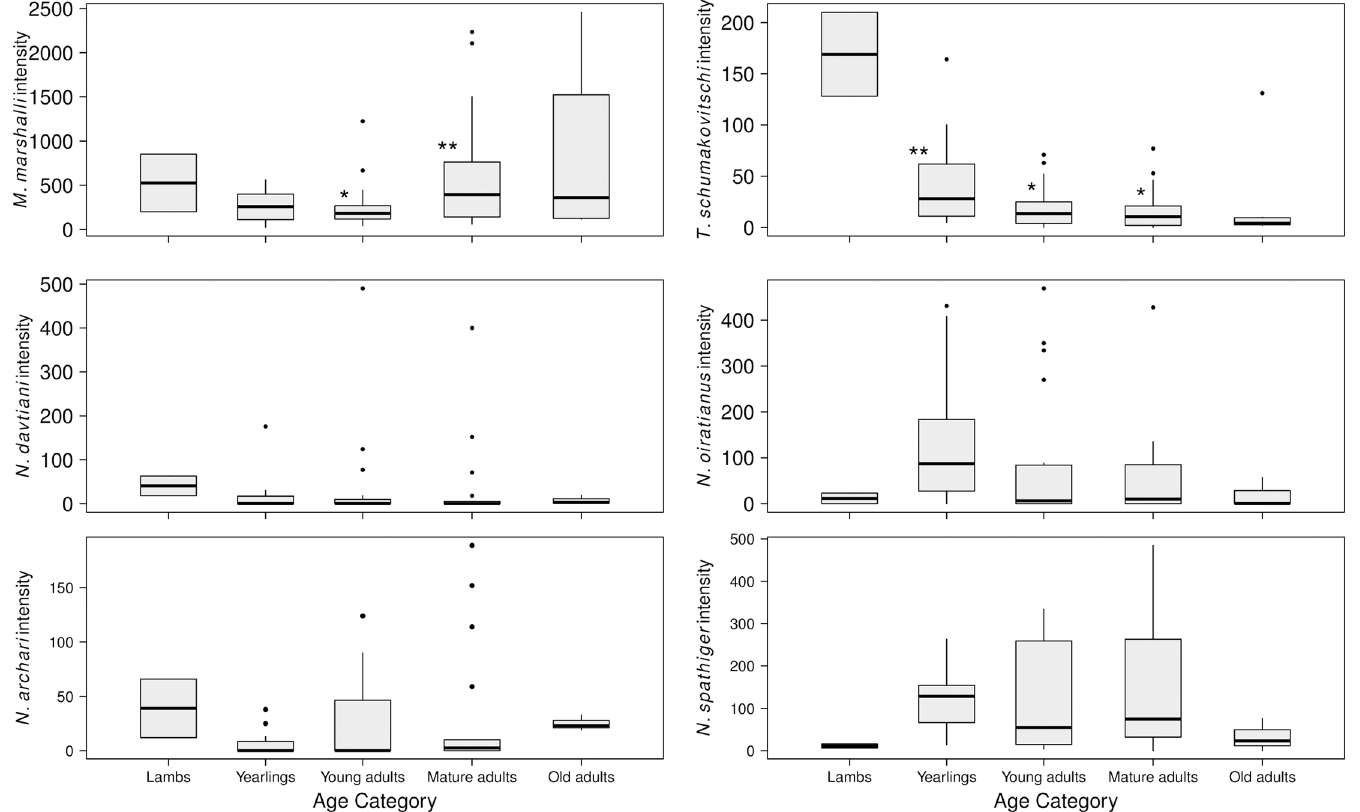
Fig 2. Infection intensity of gastrointestinal helminth species in adult Dall’s sheep categorized by age class. Lambs and old adults were excluded from pairwise comparison because of small sample size (n < 5). Significant difference among categories (p < 0.05) are represented with “ (cid:3) ”.